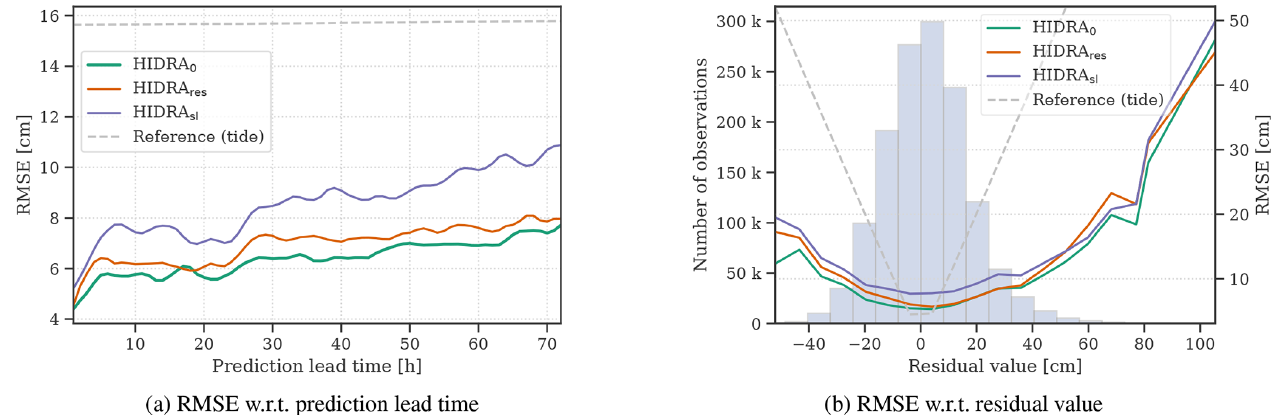
Figure 6. Performance comparison of HIDRA sea level input variants. HIDRA 0 is compared with residuals-only model HIDRA res , which does not use the estimated tide signal at the input, and the sea-level-only model HIDRA sl , which does not use separate tidal estimation and predicts the entire sea level signal. The RMSE with respect to (a) prediction lead time and (b) residual value bins is reported. The errors of the astronomic tide are presented for reference.